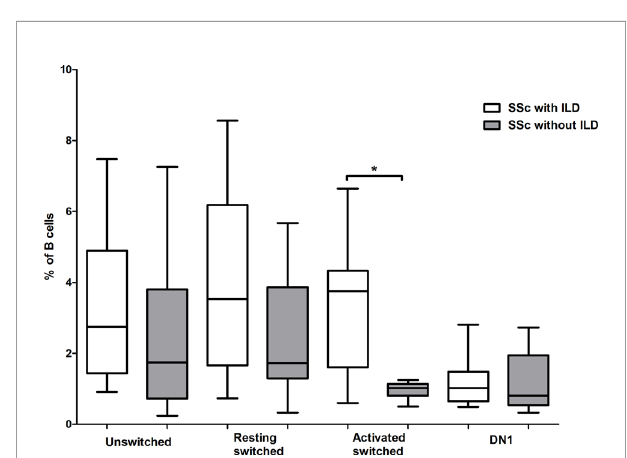
FIGURE 4 | Alterations in the percentage of memory B cell subsets in patients with interstitial lung disease (ILD). The distribution of CD19+ IgDloCD27+CD38+ unswitched, CD19+IgD − CD27 − CD38+ double negative (DN) 1, CD19+IgD − CD27+CD38+CD95 − resting switched and CD19+IgD − CD27+CD38 − CD95+ activated switched memory B cells are shown in SSc patients with ILD (n = 11) and without ILD (n = 10). The boxes show interquartile ranges (IQR), the horizontal lines represent medians and the whiskers indicate the lowest and highest values. *p <0.05.